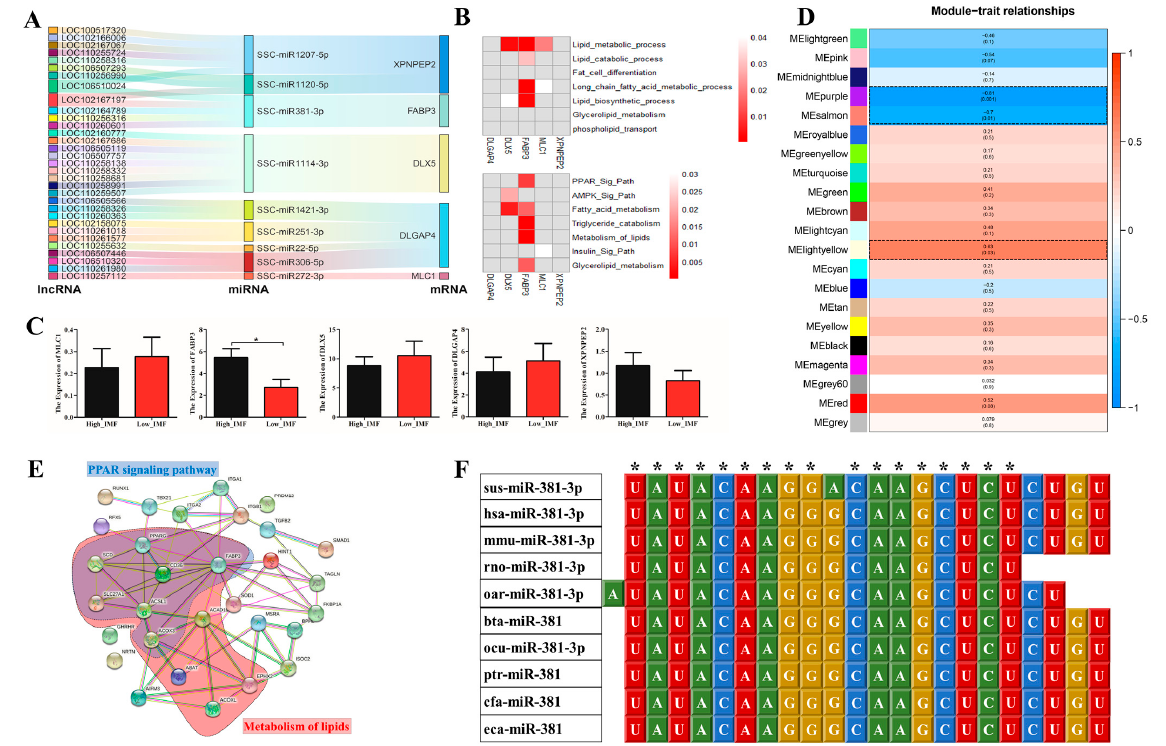
Figure 3. ceRNA regulatory network construction and WGCNA between high and low IMF in crossbred pigs (Berkshire × AQSW). ( A ) Sankey diagram of the ceRNAs network in longissimus dorsi tissue. Each rectangle represents a gene, and the degree of connection of each gene is expressed based on the size of the rectangle. ( B ) GO and KEGG enrichment analysis of the five DE target genes in ceRNAs; ( C ) the mRNA expression of five DE target genes in longissimus dorsi tissue between high and low IMF. ( D ) Module–trait associations of longissimus dorsi tissue between high and low IMF. Each row corresponds to a module epigene, while each column corresponds to IMF. Each cell contains the corresponding correlation and p -value. The table is colour-coded by correlation according to the colour legend. The black solid box represents the significance of the modules associated with IMF. ( E ) The interaction network of FABP3 in the MElightyellow module of the IMF. The hub genes of PPAR signalling pathway and lipids metabolism in the modules are denoted by blue and red shadow. ( F ) Sequence alignment analysis of miRNA-381-3p . sus, Sus scrofa; hsa, Homo sapiens; mmu, Mus musculus; rno, Rattus norvegicus; oar, Ovis aries; bta, Bos taurus; ocu, Oryctolagus cunicu-